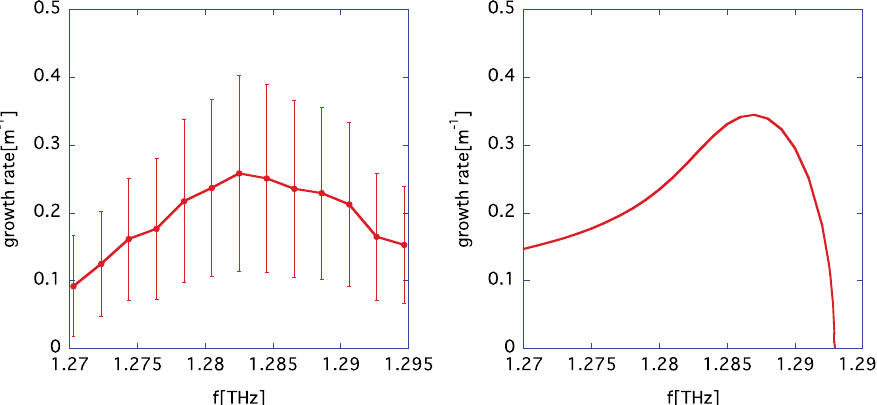
FIG. 1. The simulation (left) and the theoretical (right) results of the beam growth rate for R 0 ¼ 0 . 5 mm, γ 1 ¼ 9 . 98043 and γ 10 . 0196 2 ¼